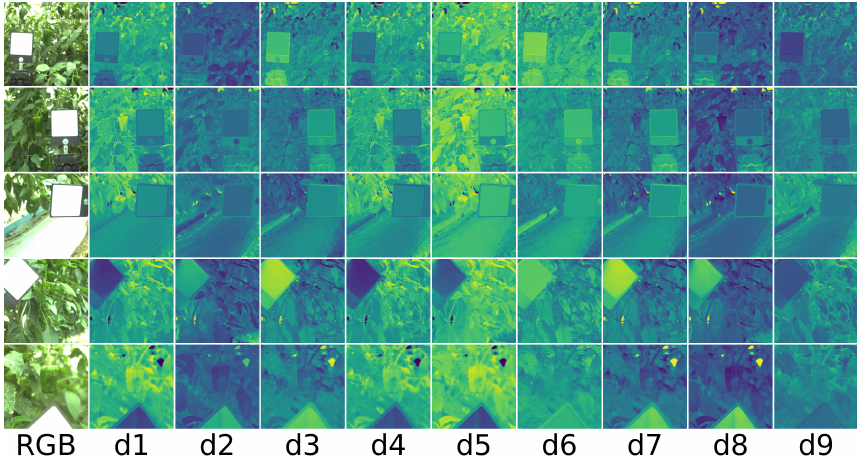
Figure 5. The above figures illustrate color-ratio maps of each test data. The first column shows five different RGB images. The second column to the tenth column shows the different color-ratio maps defined in Equations (6) and (7) for each RGB image in the same row. All color-ratio maps are shown in the same range [0, 1].